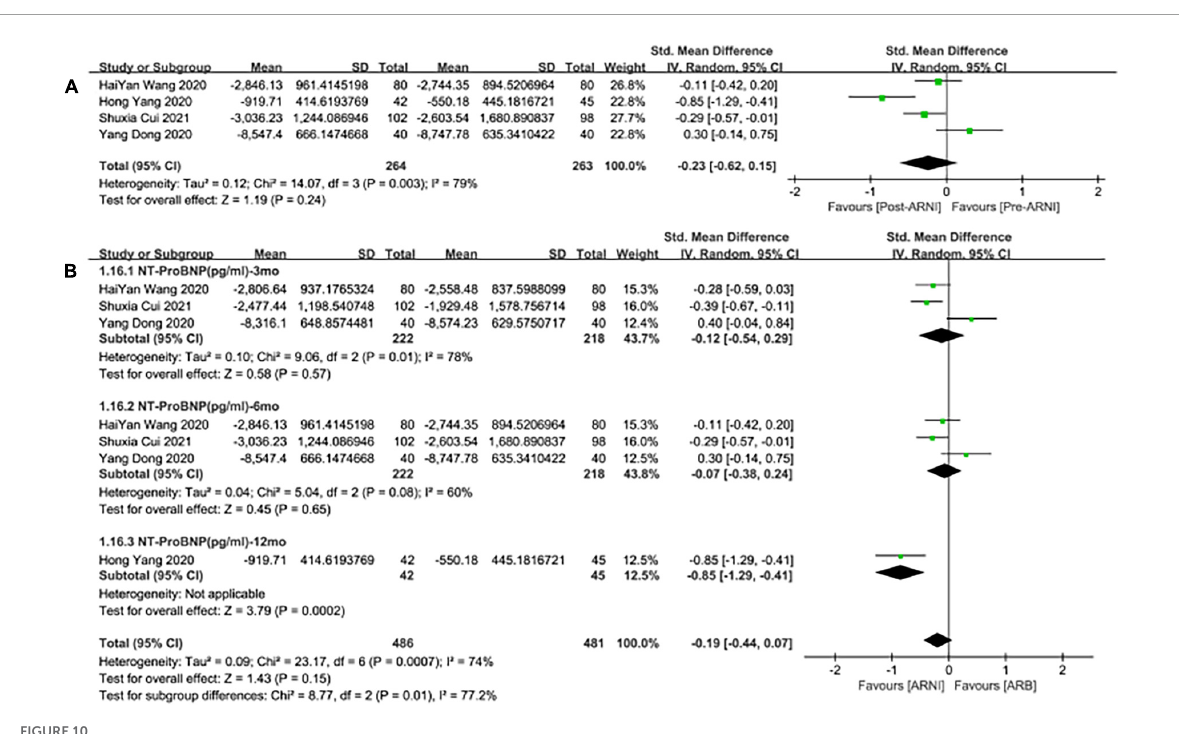
FIGURE10 Forest plots for the effect of ARNI on remodeling biomarkers in contrast with ARBs (A) and subgroup analysis (B)